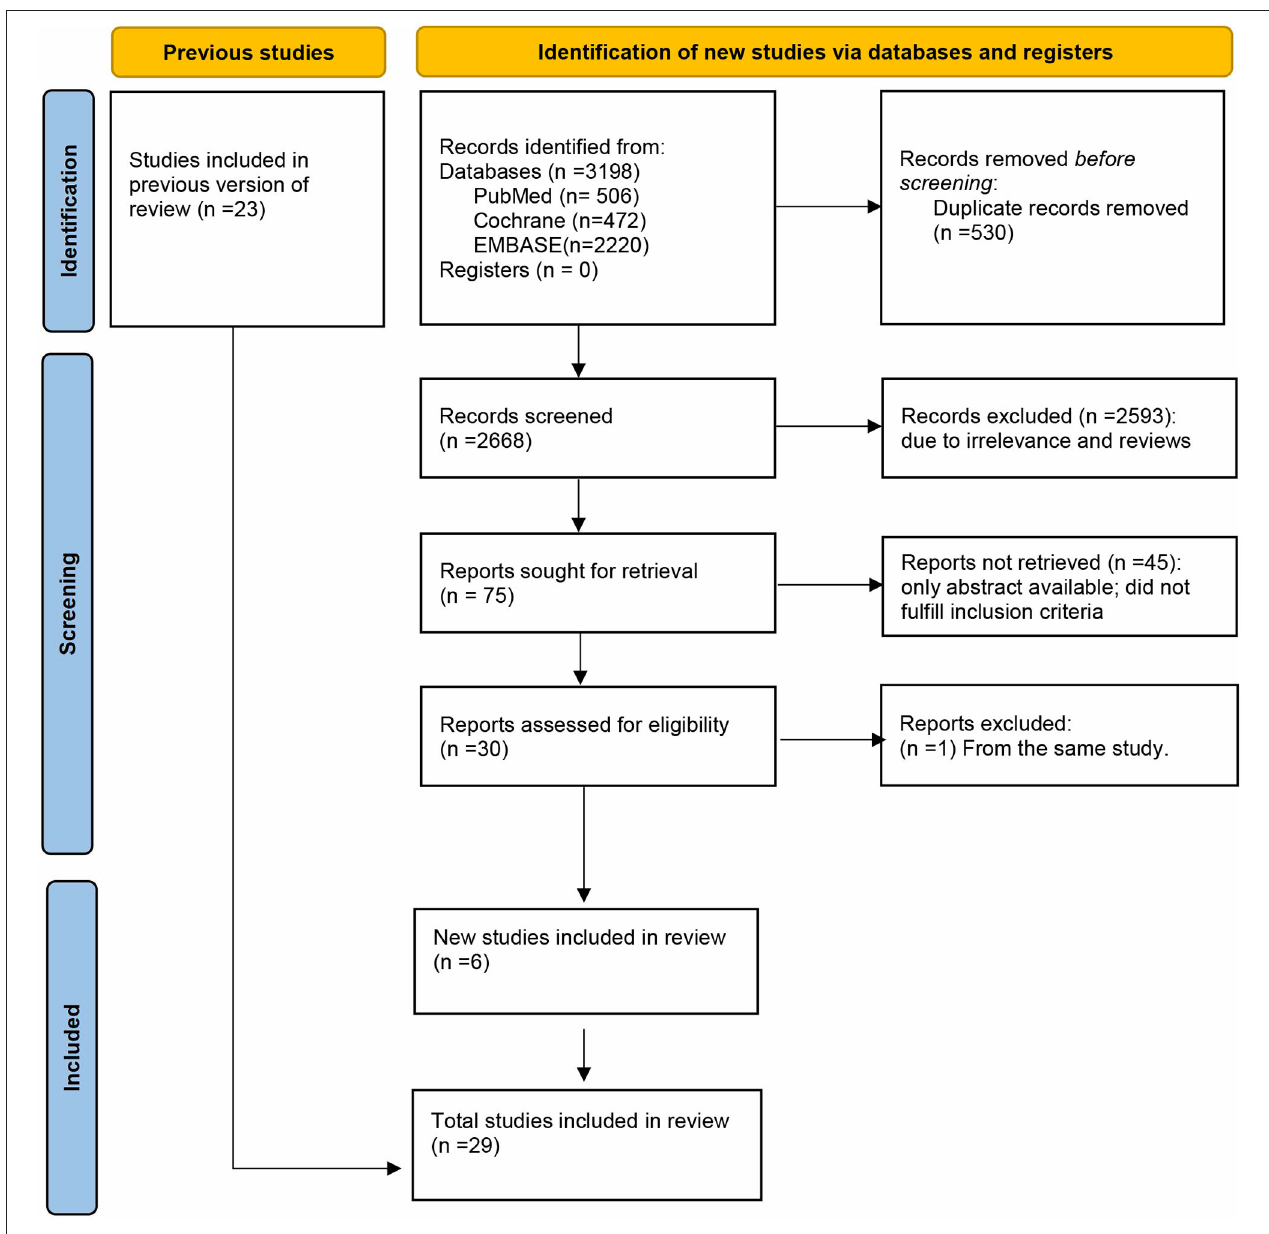
FIGURE 1 | PRISMA flow diagram of the study